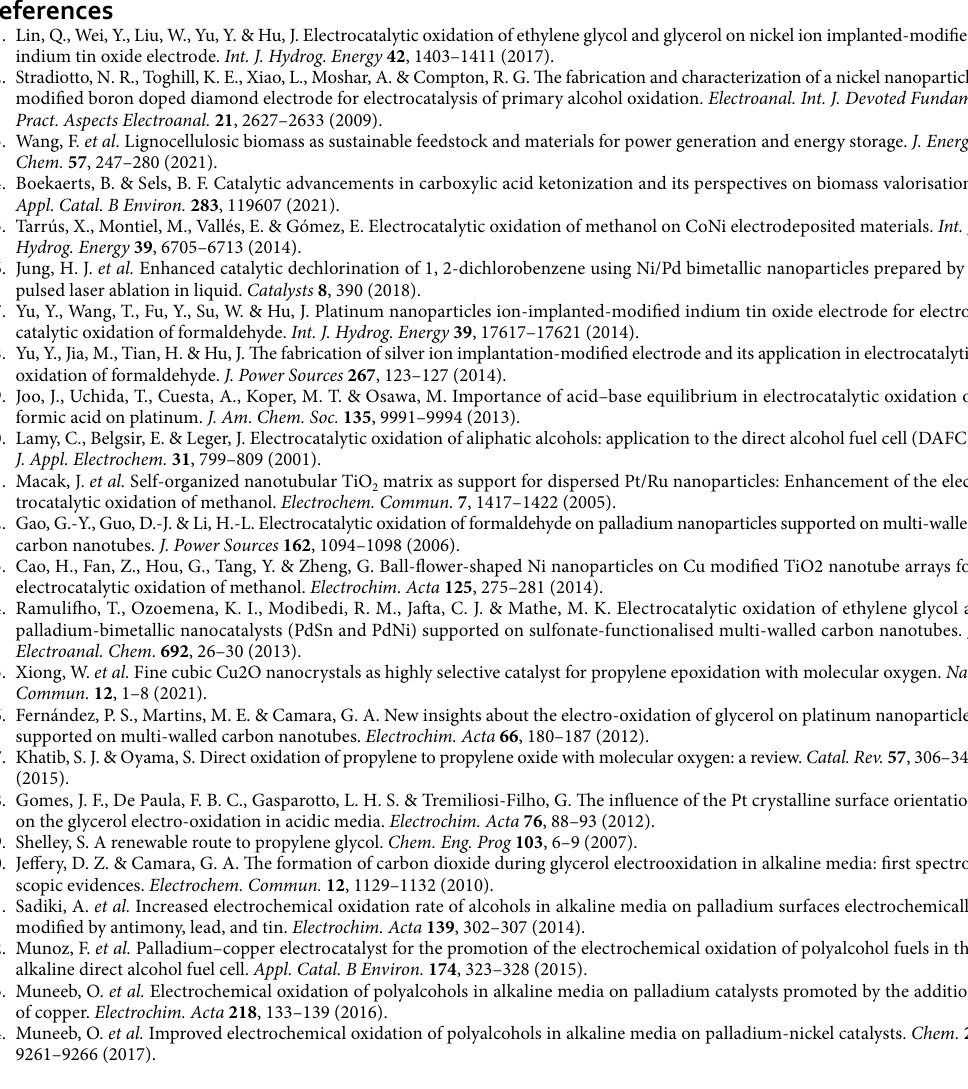
3. Electrochemical measurements discovered the exceptional electrocatalytic activity of nano-catalyst for oxi- dizing propylene. 4. Propylene oxidation progression was following diffusion – controlled process at electrocatalyst surface. 5. Enhancing CNT content developed the attained anodic peak current until greatest performance at the elec- trocatalyst comprising 40 mg of CNT. 6. The proposed SMWZCPE modified electrode shows acceptable stability towards propylene glycol oxidation.